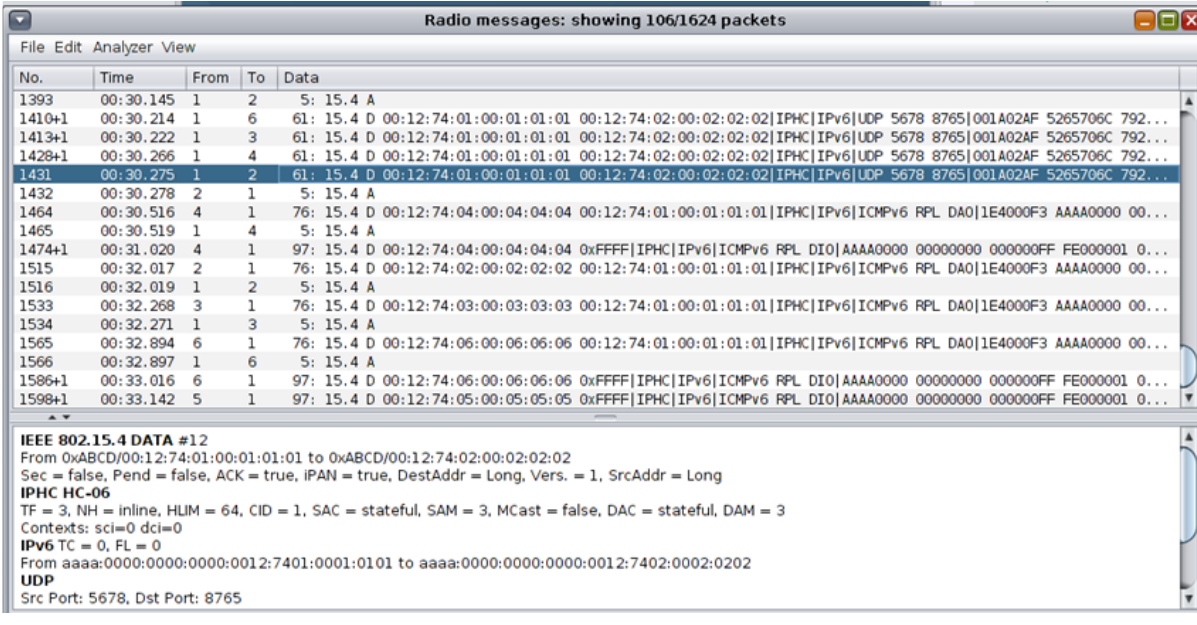
Figure 15. Network traffic information from the benign scenario in t he “Radio messages” output window .